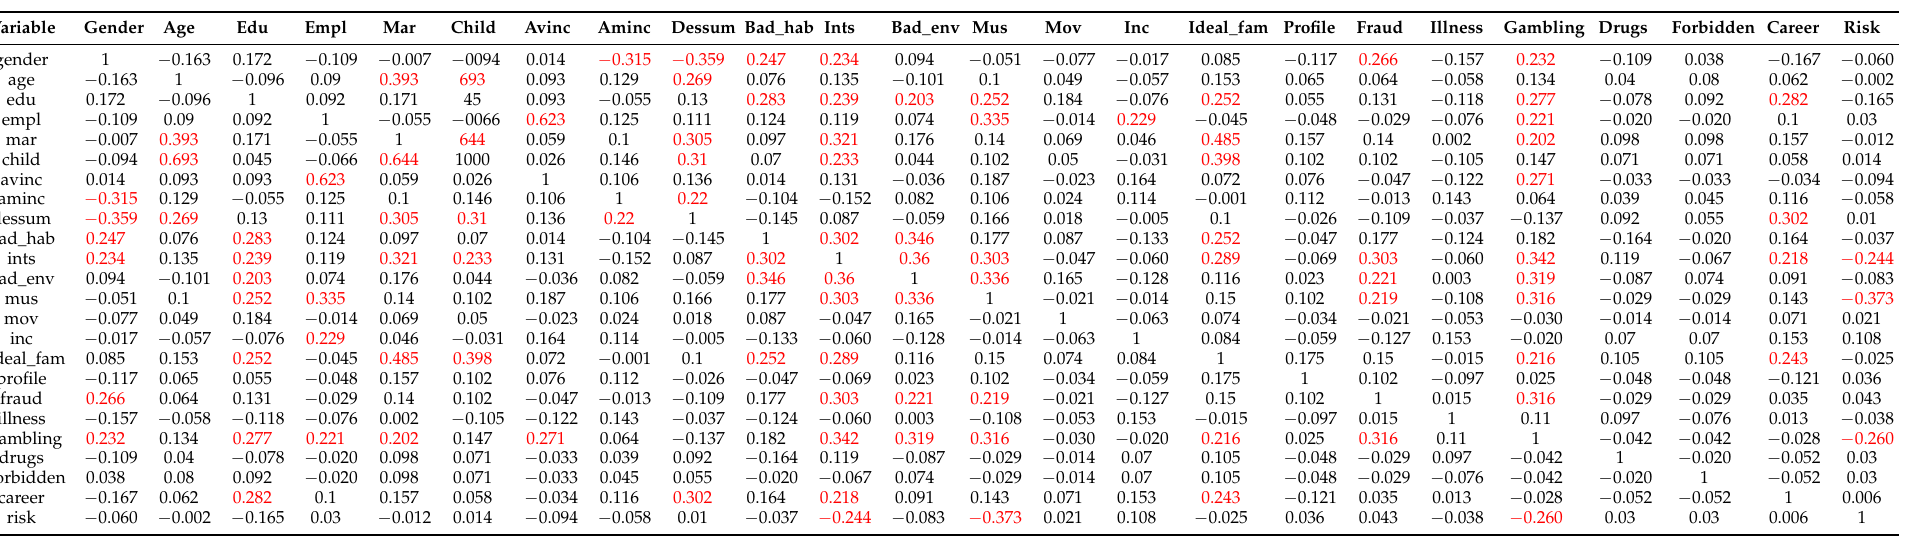
Table 4. Partial correlations matrix (significant parameters are marked in